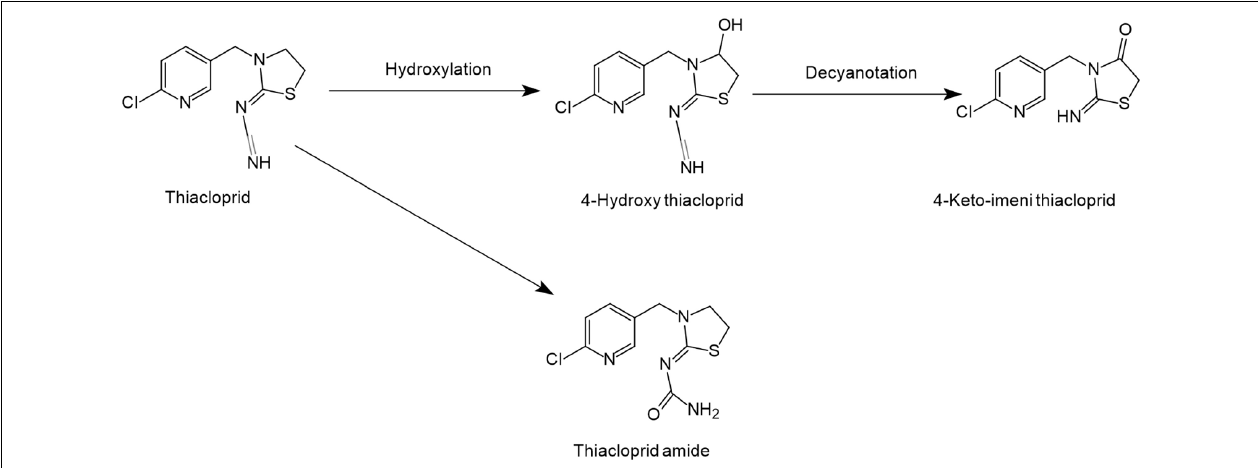
FIGURE 3 | Microbial degradation pathways of thiacloprid (based on Zhao et al., 2009; Thurman et al., 2013).